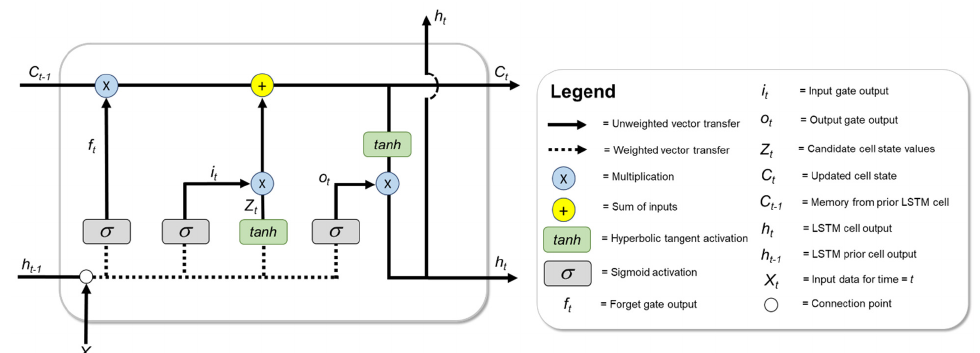
Figure 5. Example schematic of an LSTM cell. Figure concept compiled from concepts presented in Kwak & Hui [131], Olah [132], and Poornima & Pushpalatha [133].